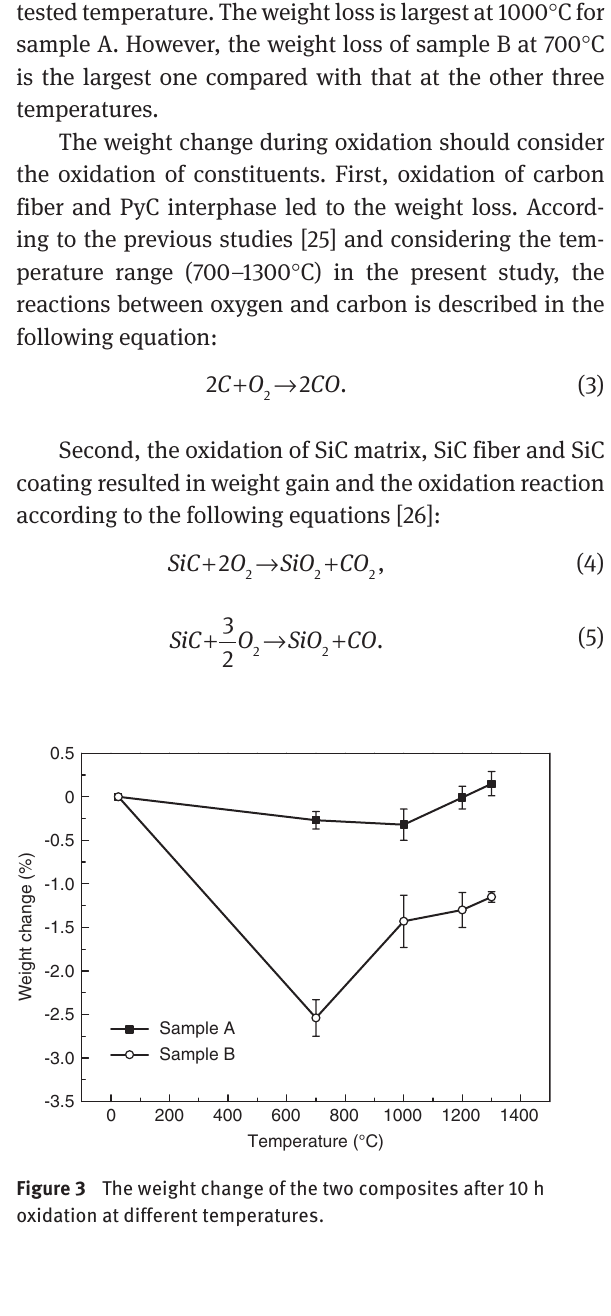
Figure 3 The weight change of the two composites after 10 h oxidation at different